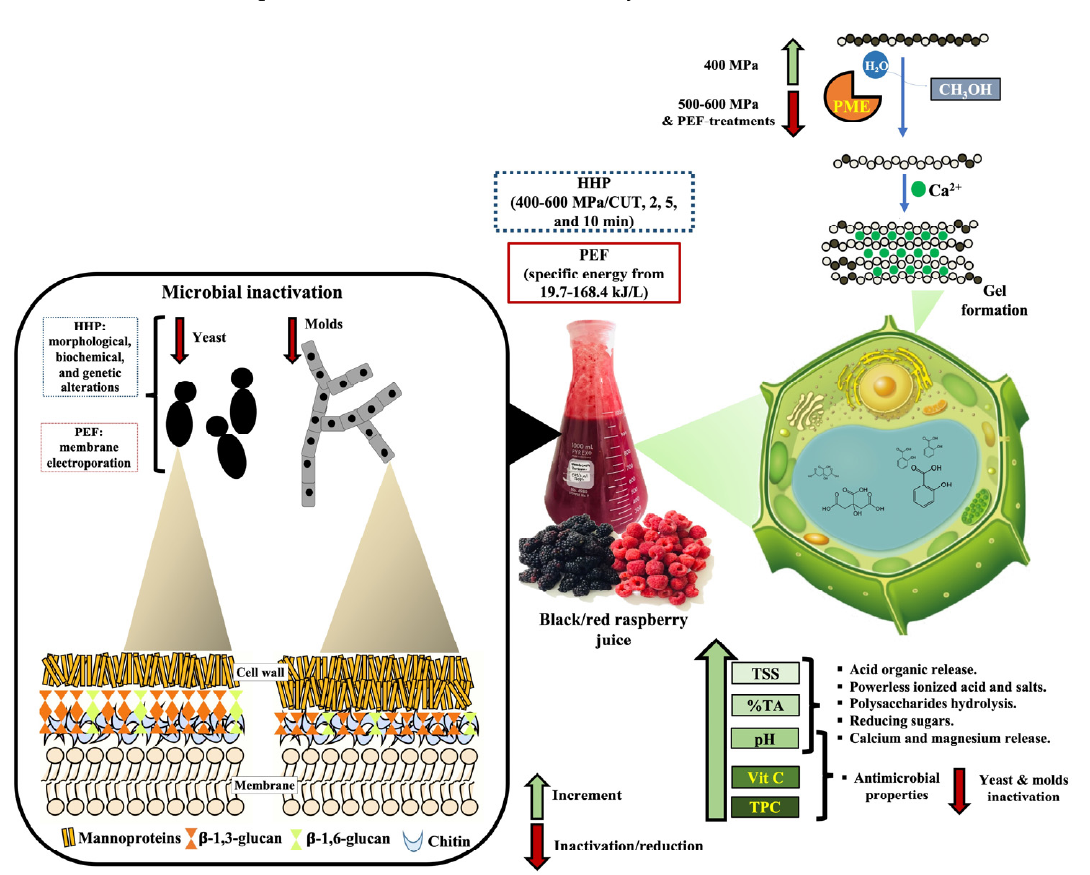
Figure 2. Putative effect of the high hydrostatic pressure and pulsed electric field on the microbial safety, enzyme inactivation, and phytochemical retention in the black/red raspberry juice. Yeast and molds cell structure adapted from Ref. [36] and PME reaction adapted from Ref.